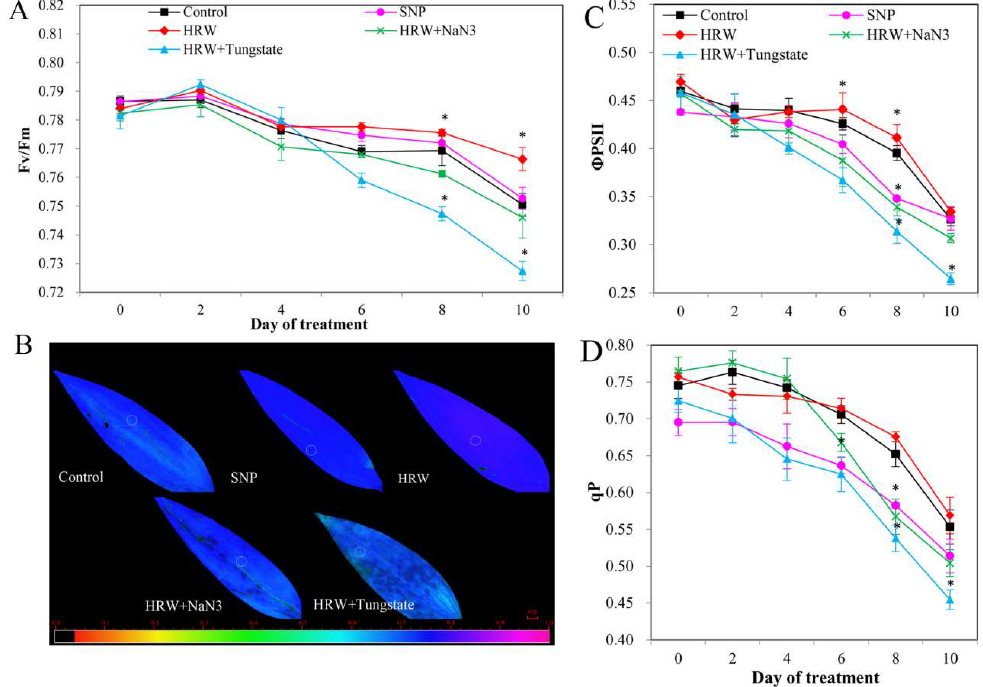
Figure 6. Effects of HRW, SNP, and HRW plus NaN 3 or tungstate on chlorophyll fluorescence parameters. Values of the Fv/Fm (maximum quantum yield of PSII photochemistry) ( A ); effective quantum yield of PSII (ΦPSII) ( C ); and photochemical quenching (qP) ( D ) are the mean ± SE of three independent experiments with three repeats for each. Fluorescent images ( B ) are given in colors that represent the absolute values of the ratio ranging from 0 (black) to 1.0 (purple) and were taken on the 8th day of treatment. Asterisks indicate significant difference ( p < 0.05 by Duncan’s multiple range test) compared to the control within the same